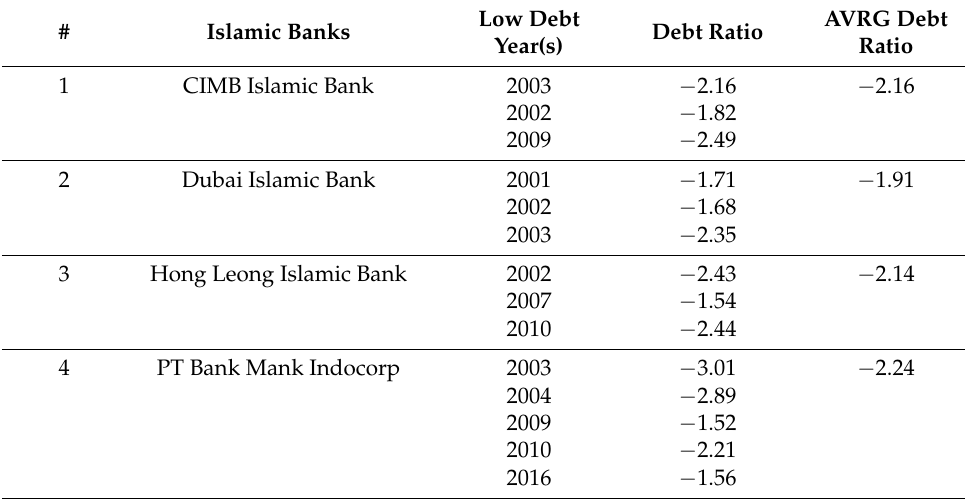
Table 4. Low Excess Leverage among Islamic